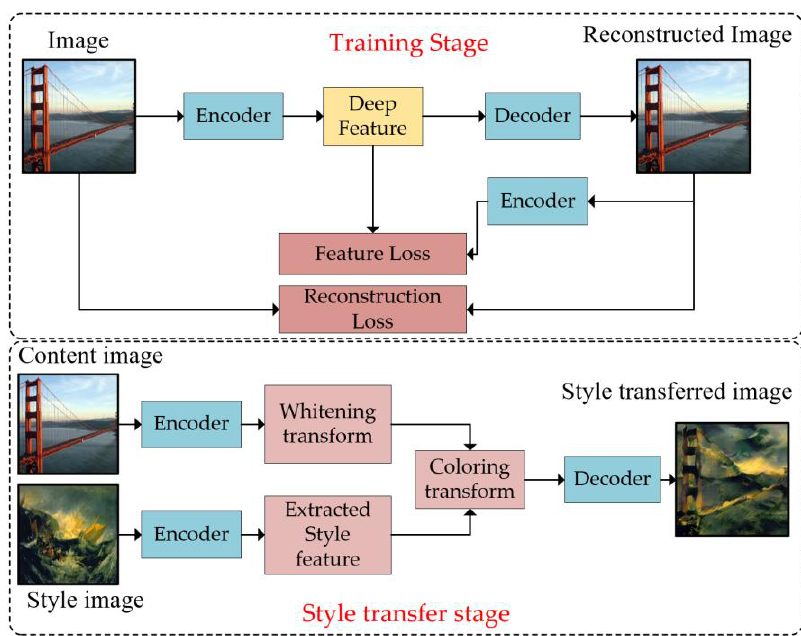
Figure 4. Network architecture of PhotoWCT.